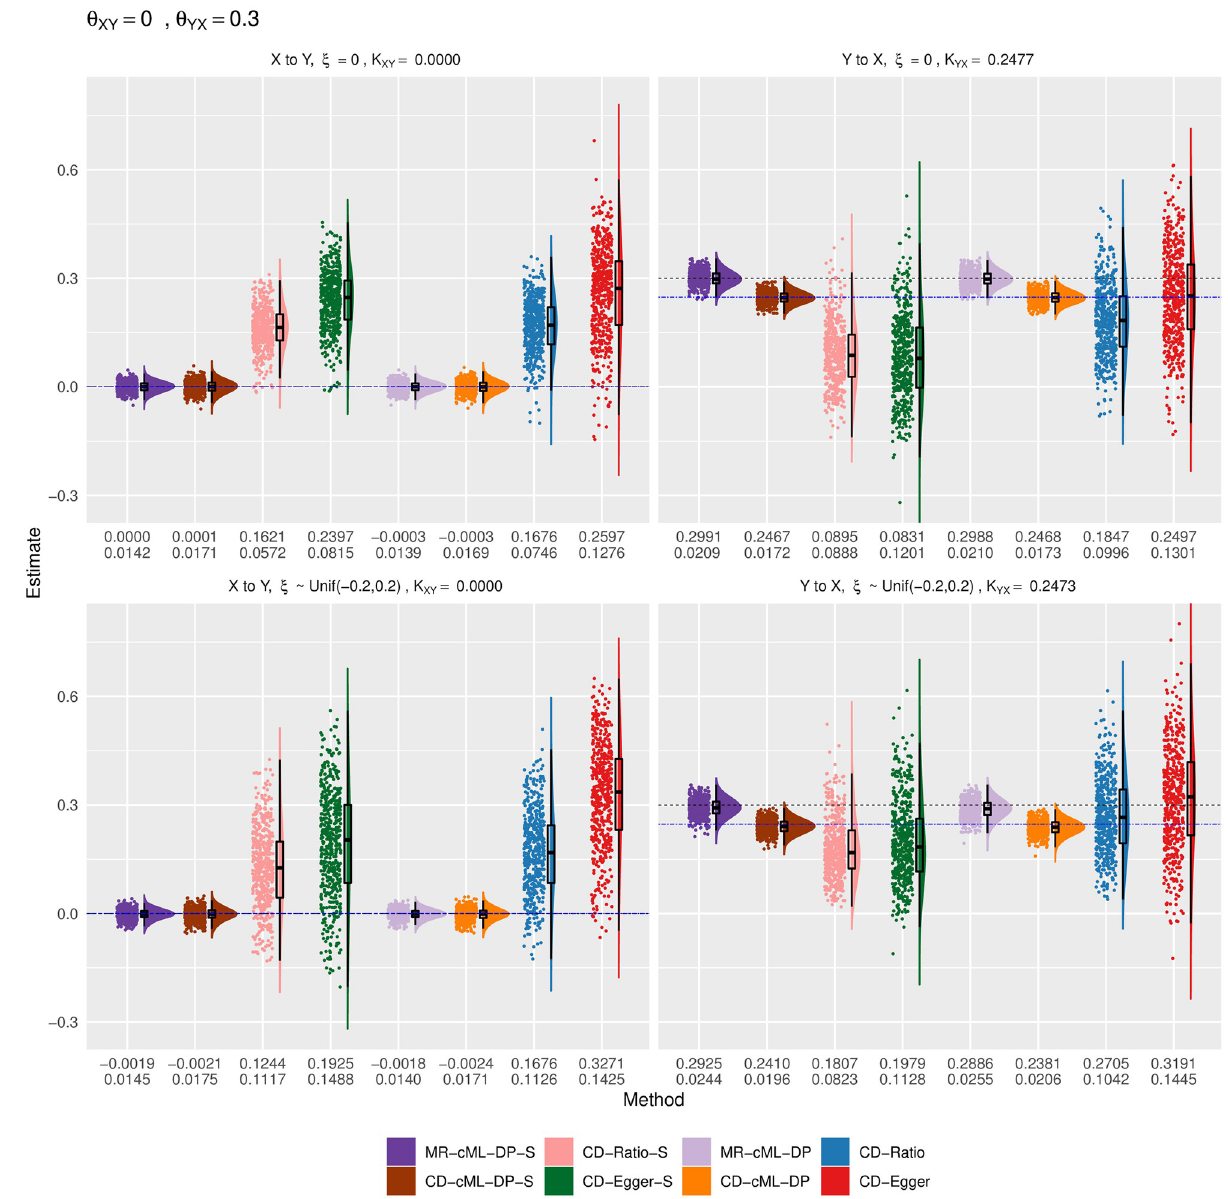
Fig 7. Empirical distributions of the estimates of the correlation ratio K for CD methods and the causal effect θ for MR method with both X and Y continuous, true θ XY = 0 and θ YX = 0.3. The top and bottom panels show the results for ξ = 0 (i.e. no correlated pleiotropy) and ξ from a uniform distribution (i.e. with correlated pleiotropy, implying InSIDE violated), respectively. The left panels show the estimates for the causal direction of X ! Y , while the right ones show that for Y ! X . The horizontal dashed lines are for the true values of K (in blue) and θ (in black). The two rows of the numbers under each panel give the sample mean and standard deviation of the estimates from each